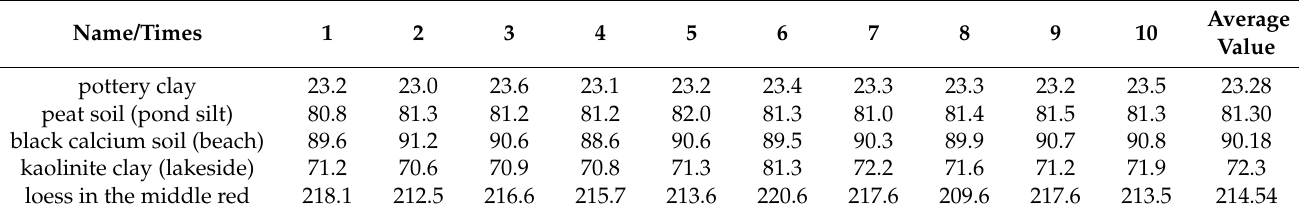
Table 3. The resistivity value of the developed soil resistivity measurement (unit: Ω · m).